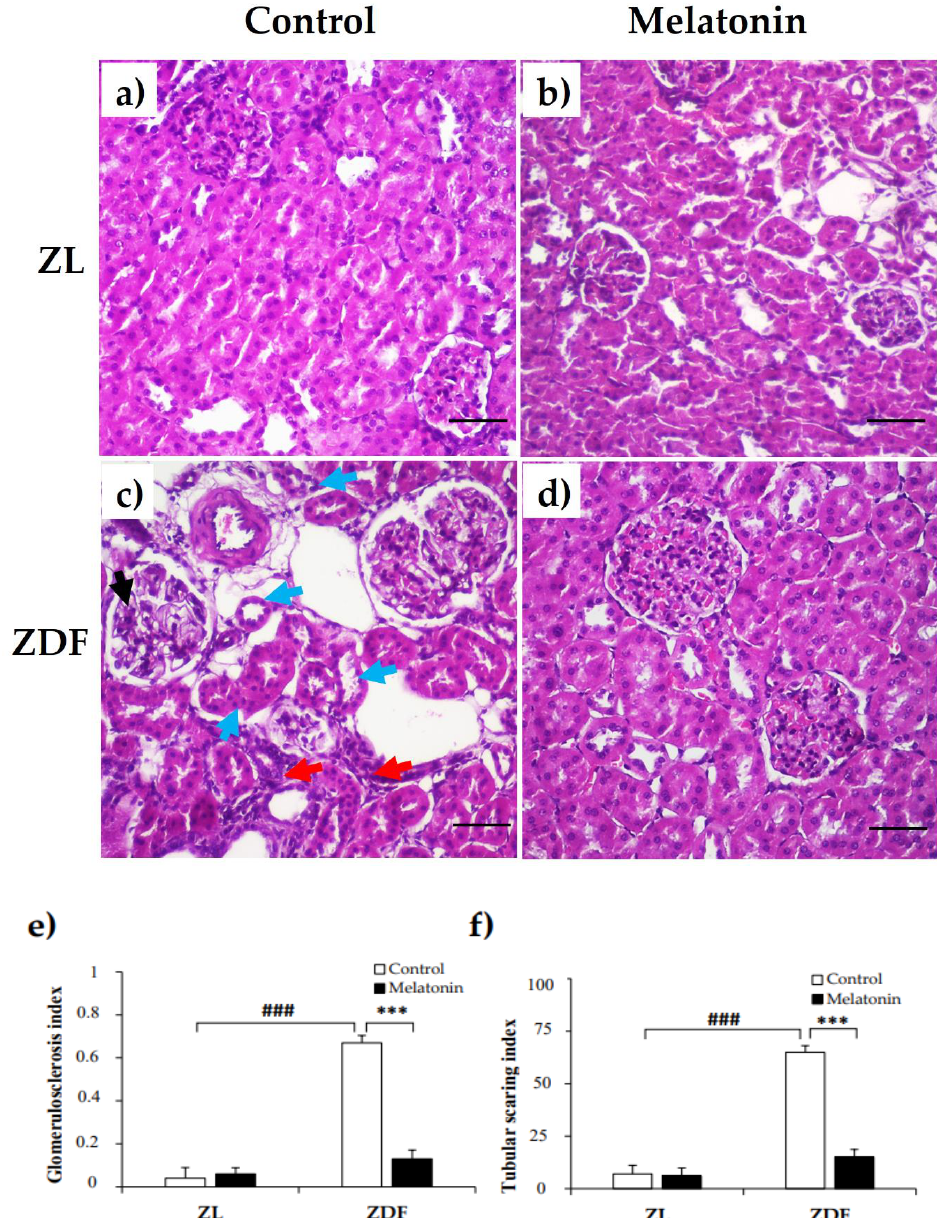
Figure 3. Effects of melatonin on renal tissue morphology of Zücker lean and diabetic fatty rats. ( a , b ) Representative photomicrographs showing normal appearance of the glomerulus and tubules in C–ZL (left panel) and M–ZL rats (right panel). ( c ) Early focal segmental glomerulosclerosis (FSGS) and tubulointerstitial damage were noted in C–ZDF rats, with a left glomerulus showing segmental mesangial hypercellularity and mild segmental endocapillary (black arrow) and on the right showing hypertrophy, associated with interstitial fibrosis (red arrows) and mild tubular degeneration as shown with epithelial cells atrophy and loss of brush borders and cell polarity (blue arrows). ( d ) Normal structure of renal tissue was observed in M–ZDF rats, with lower severity of FSGS and normal renal tubules, and no signs of fibrosis. (H&E stain; original magnification at × 100). ( e , f ) Semi-quantitative analysis of glomerulosclerosis index (left panel) and tubular index (right panel) scores in ZL and ZDF rats. C–ZL: control lean rats without melatonin; M–ZL: lean rats with melatonin; C–ZDF: control diabetic fatty rats without melatonin; M–ZDF: diabetic fatty rats with melatonin; ZL: Zücker lean rats; ZDF: Zücker diabetic fatty rats. Values are means ± S.E.M ( n = 6). ### p < 0.001 C–ZDF vs. C–ZL; *** p < 0.001 M–ZDF vs. C–ZDF (Tukey post hoc test). Scale bar: 200 µ